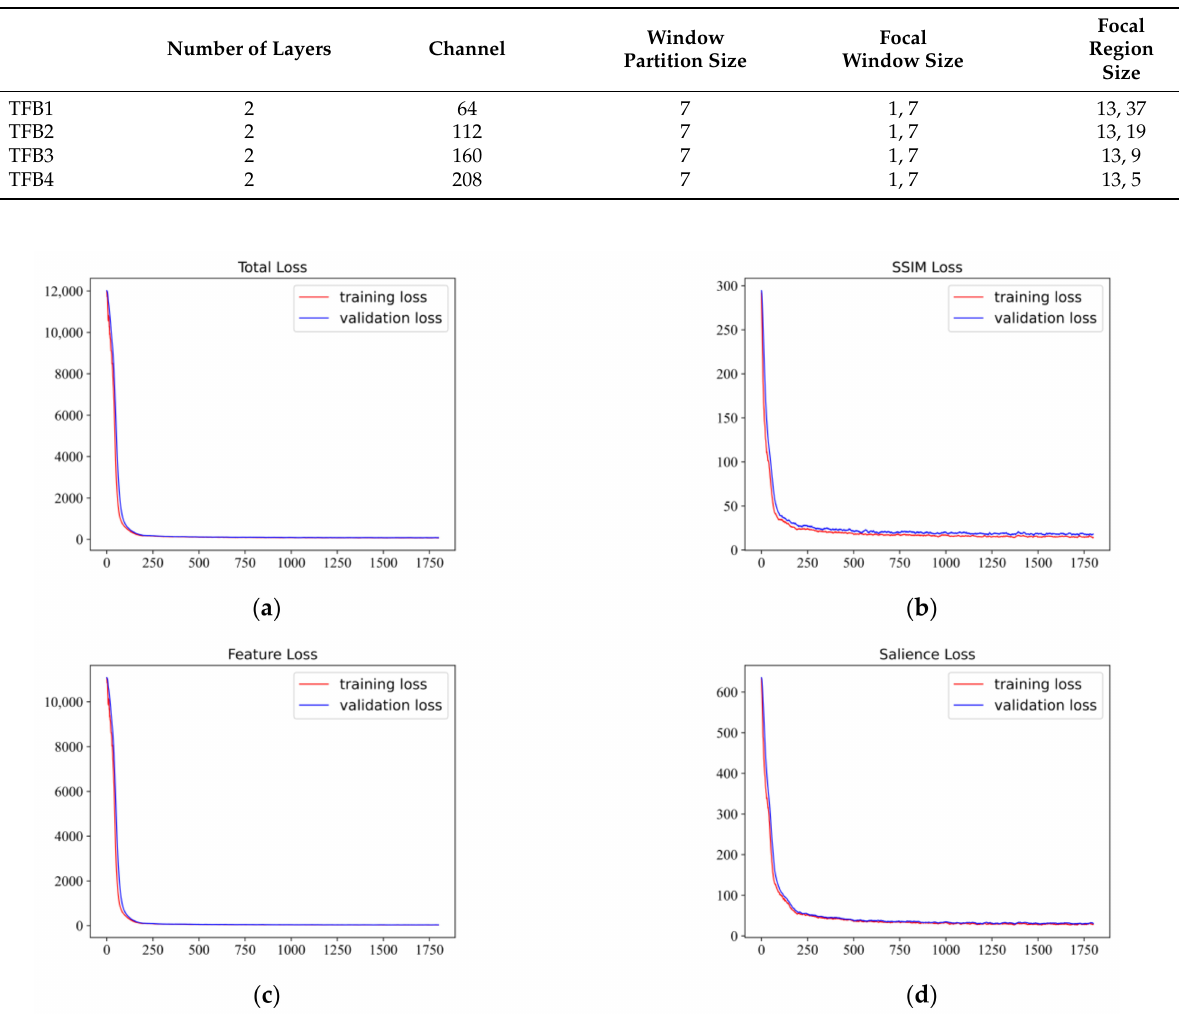
Figure 5. Fusion loss curves over 1800 iterations. ( a ) shows the training and the validation curves of total loss. ( b – d ) are training and the validation curves of SSIM loss, feature loss and salience loss